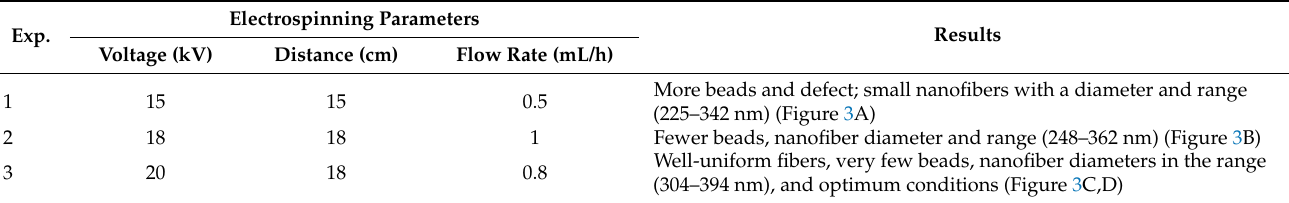
Table 1. Process conditions and the corresponding findings.